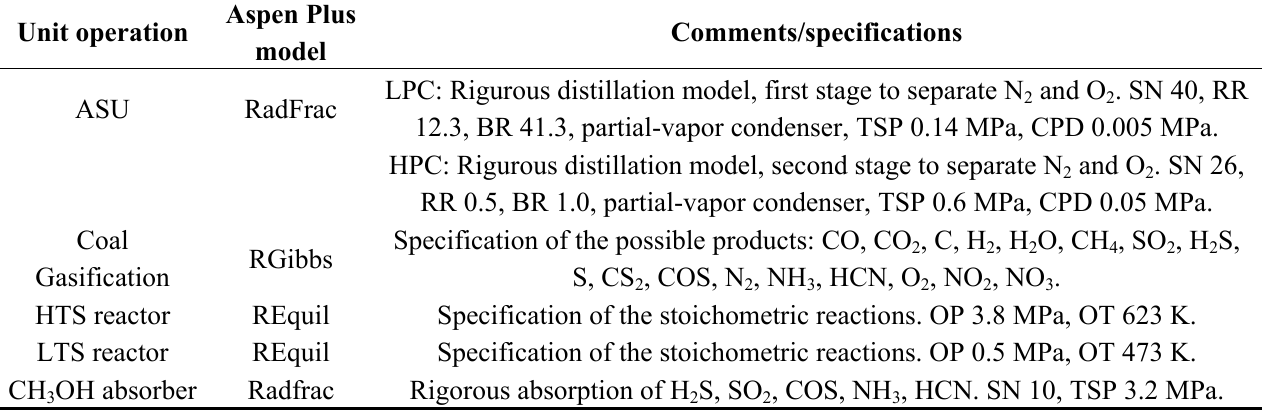
Table 3. Main blocks used in the